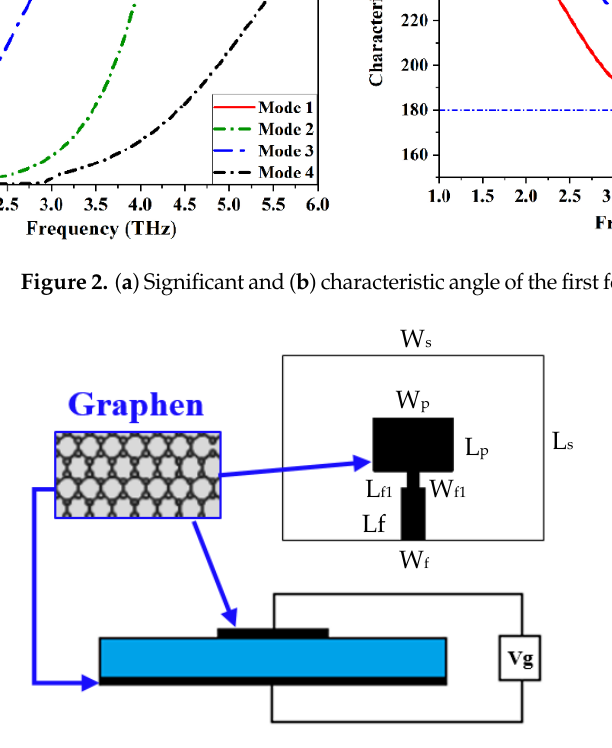
Figure 3. Schematic of the graphene plasmonic patch antenna. Table 1. The proposed antenna parameters.